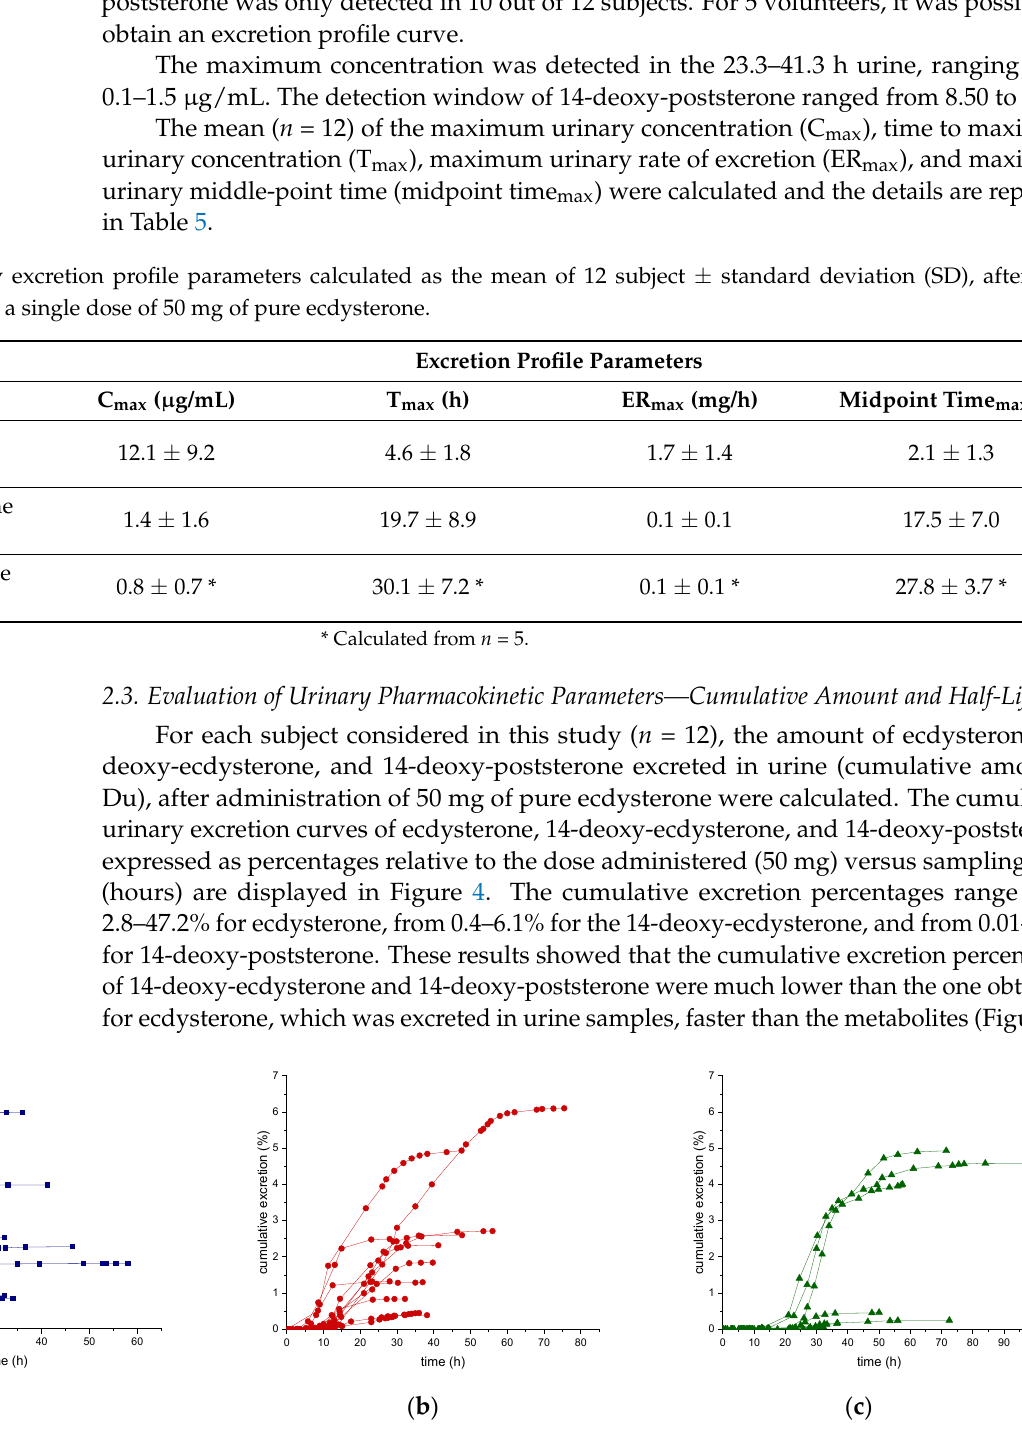
Figure 4. Cumulative urinary excretion curve of ecdysterone ( a ), 14-deoxy-ecdysterone ( b ), and 14-deoxy-poststerone ( c ), following a single-dose administration of 50 mg pure ecdysterone in male and female ( n = 12).